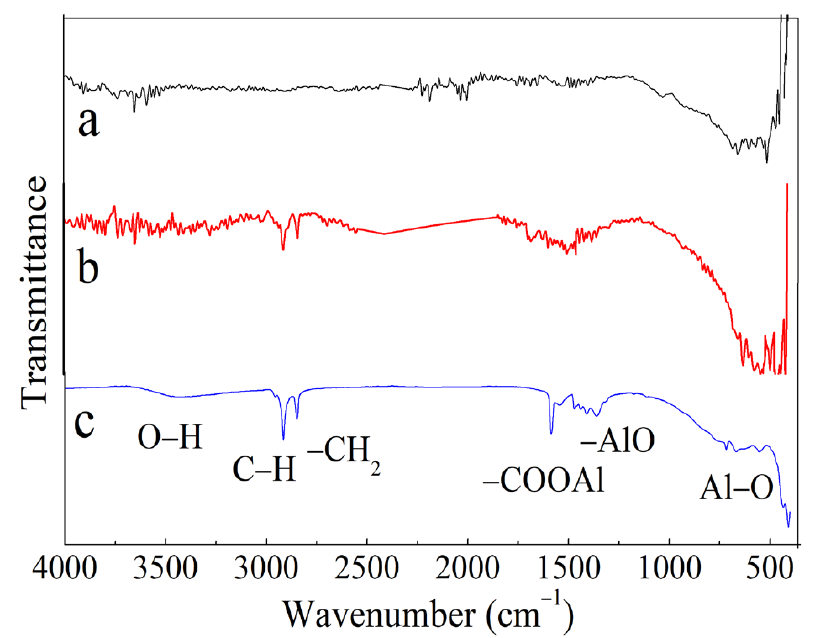
Figure 5. FTIR spectra of (a) untreated aluminum alloy, (b) stearic-acid-treated aluminum alloy after Na 2 CO 3 etching and (c) stearic-acid-treated aluminum alloy after NaOH etching at 90 °C. Digital images of surfaces on stearic-acid-treated samples after Na 2 CO 3 etching and stearic-acid-treated samples after NaOH etching at 90 ◦ C before and after abrasion tests were obtained to investigate mechanical durability. As shown in Figure 6a,b, the stearic- acid-treated sample after Na 2 CO 3 etching presented a silvery color, and the stearic-acid- treated sample after Na 2 CO 3 etching after the abrasion test showed a similar color. How- ever, as shown in Figure 6c,d, the stearic-acid-treated sample after NaOH etching at 90 ◦ C presented a black color and the stearic-acid-treated sample after NaOH etching at 90 ◦ C after the abrasion test showed a light gray color. Figure 6e,f show SEM images of surfaces on the stearic-acid-treated sample after Na 2 CO 3 -etching after the abrasion test and on the stearic-acid-treated sample after NaOH etching at 90 ◦ C after the abrasion test. As shown in Figure 6e,f, the stearic-acid-treated sample after NaOH etching at 90 ◦ C after the abrasion test showed a severely broken surface. As listed in Table 2, the static contact angle changed from 164.7 ◦ to 133.9 ◦ after the abrasion test. Variation of the water contact angle for the stearic-acid-treated sample after NaOH etching at 90 ◦ C was 30.8 ◦ . In contrast to the severely broken surface of the stearic-acid-treated sample after NaOH etching at 90 ◦ C after the abrasion test, the stearic-acid-treated sample after Na 2 CO 3 etching after the abrasion test showed a relatively slightly broken surface, which consisted of some slight broken micro-scale dents and intact nano-scale fibers in the micro-scale dents. As listed in Table 2, the static contact angle changed from 161.7 ◦ to 144.6 ◦ after the abrasion test. Variation of the water contact angle for the stearic-acid-treated sample after Na 2 CO 3 etching was 17.1 ◦ , which is bigger than the 10.7 ◦ variation of water contact angle for superhydrophobic surfaces on 1060 aluminum-alloy substrates in the previous literature [66]. This can be ascribed to the different aluminum-alloy substrates. In contrast to the severely broken surface and big variation of the static contact angle for the stearic-acid-treated sample after NaOH etching at 90 ◦ C, the slightly broken surface and smaller variation of the static contact angle for the stearic-acid-treated sample after Na 2 CO 3 etching indicated highly improved mechanical durability of the stearic-acid-treated sample after Na 2 CO 3